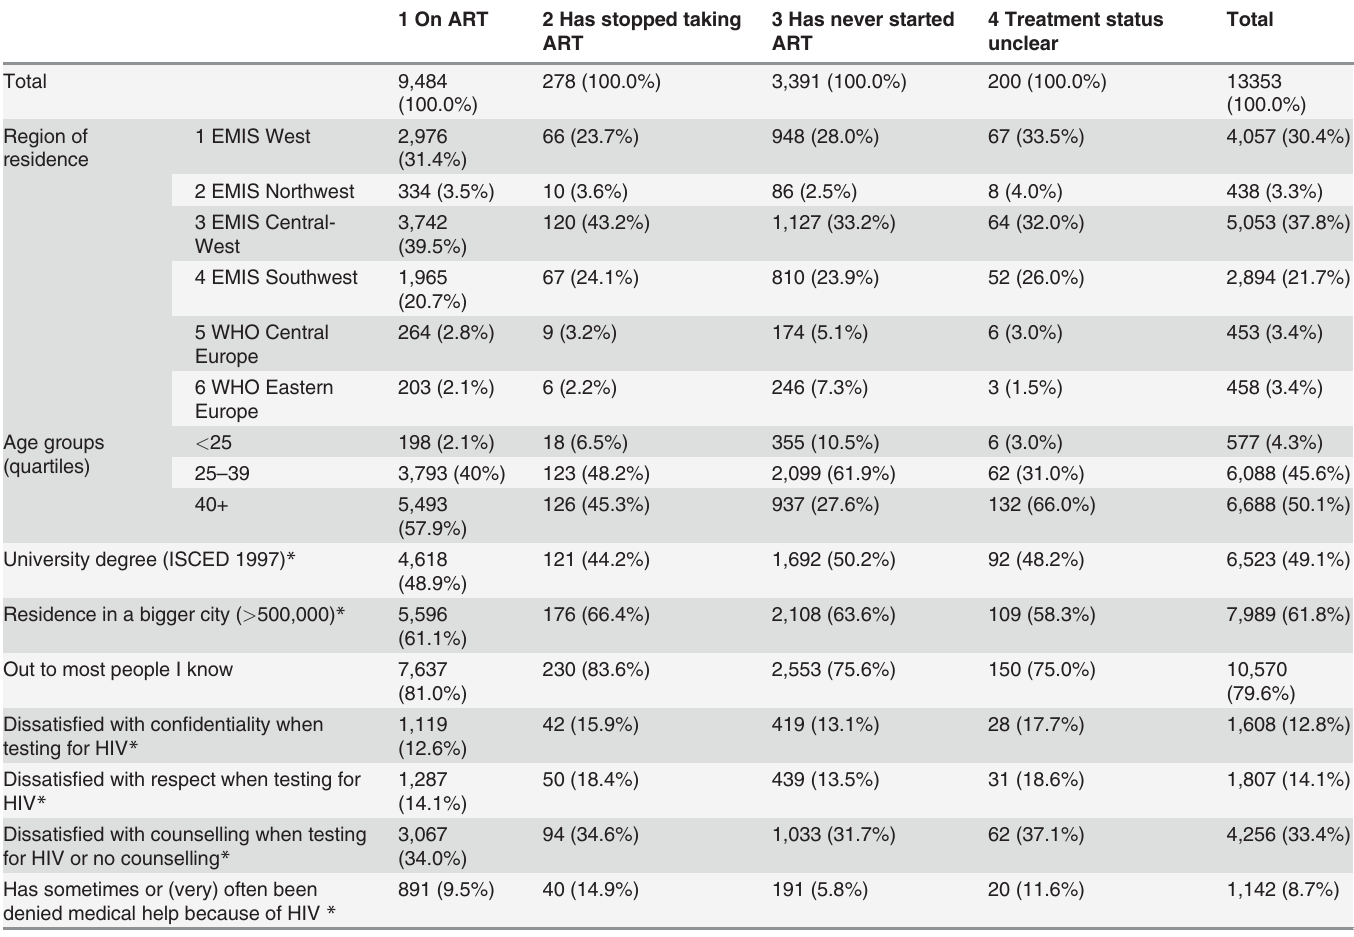
Table 1. ART treatment status by demographic variables and HIV-related health care experiences among MSM living in Europe with diagnosed